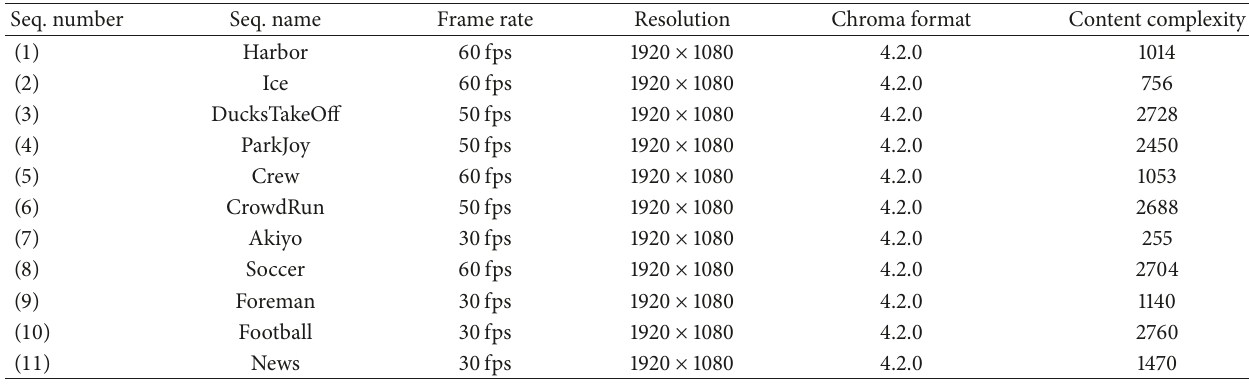
Table 1: Video sequences used.